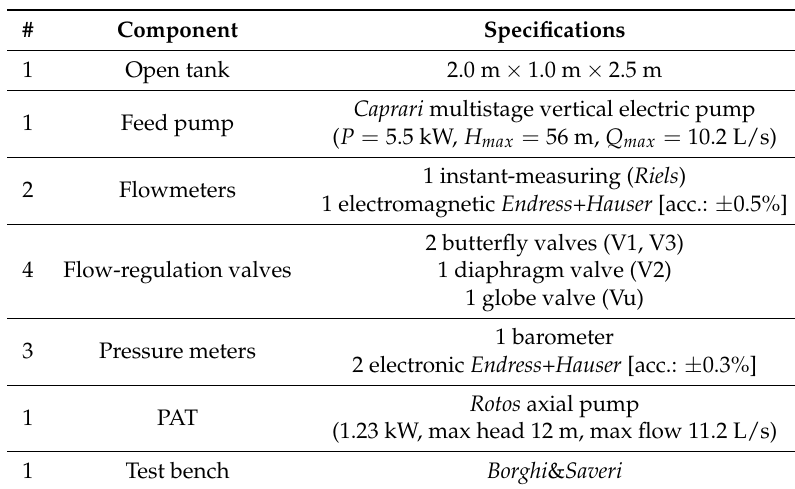
Figure 2. Experimental setup: ( a ) indication of the main elements of the supply system; and ( b ) vortex generation at the PAT outlet. Table 2. Components of the experimental setup (instrument accuracy is also